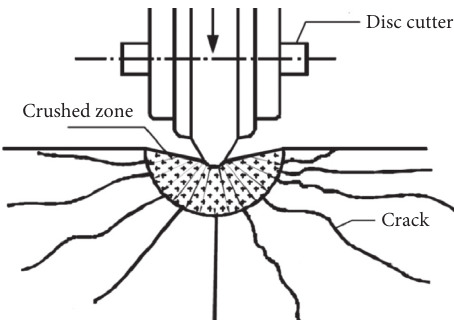
Figure 1: Schematic diagram of disc cutter’s penetration into the